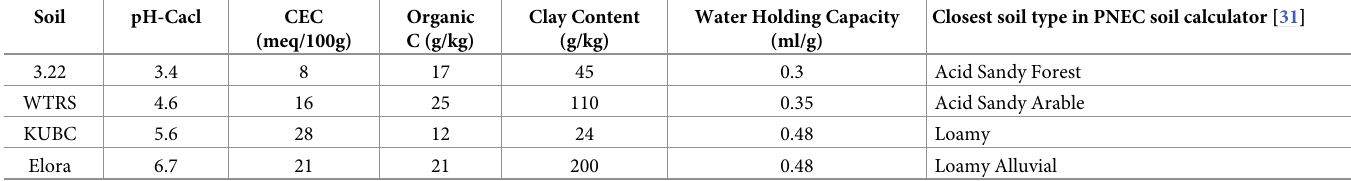
Table 1. Soil properties and closest soil type classification in soil PNEC calculator. Soil pH-Cacl